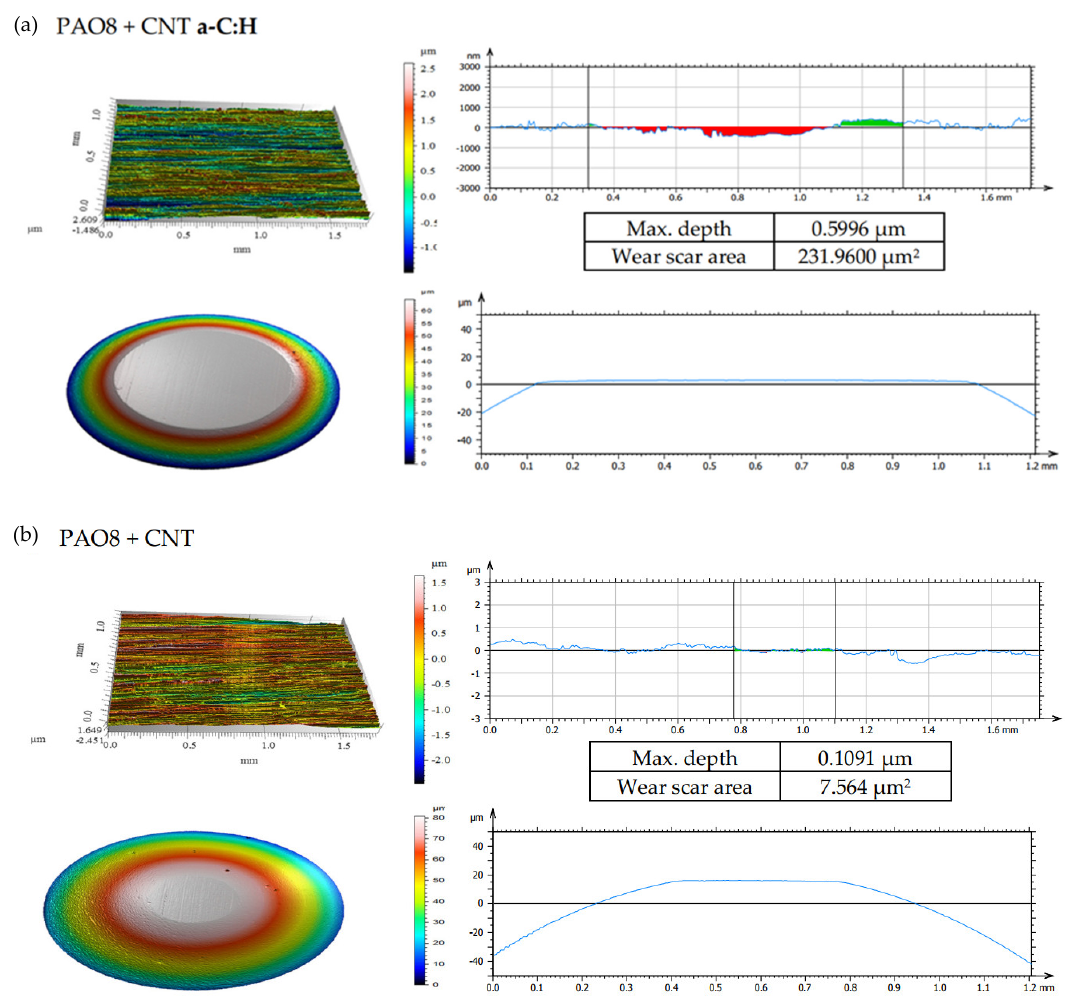
Figure 8. Isometric views and primary profiles of the discs and balls after the tribological tests of PAO8 + CNT on TRB 3 tribotester equipped with ( a ) disc coated by a-C:H and ( b ) uncoated disc. CNT, carbon nanotube.